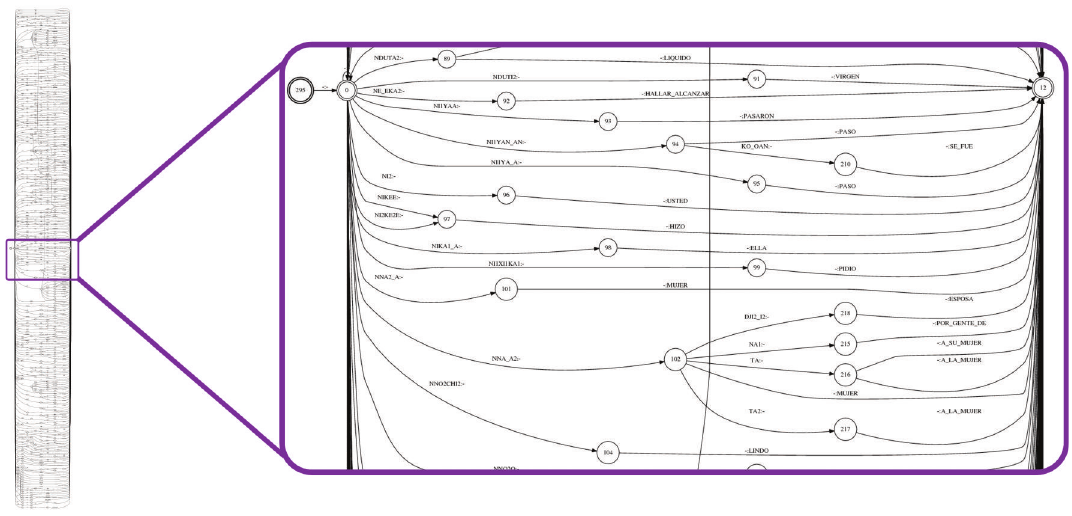
Figure 12: Fragment of the TM 𝑋𝑃 transducer.